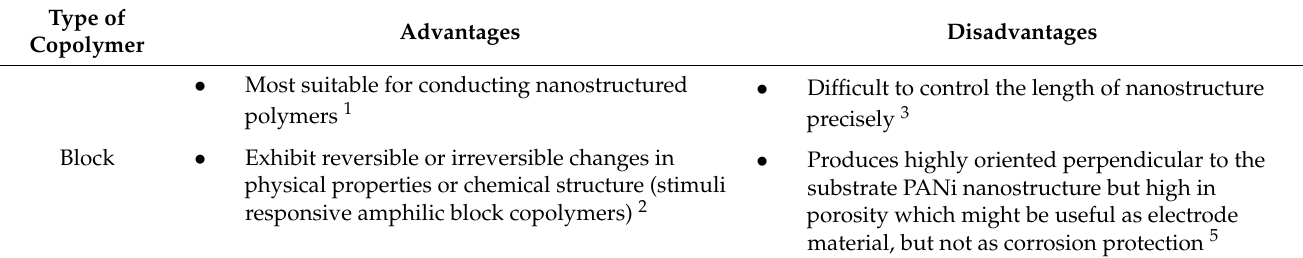
Table 6. Advantages and disadvantages of graft and block